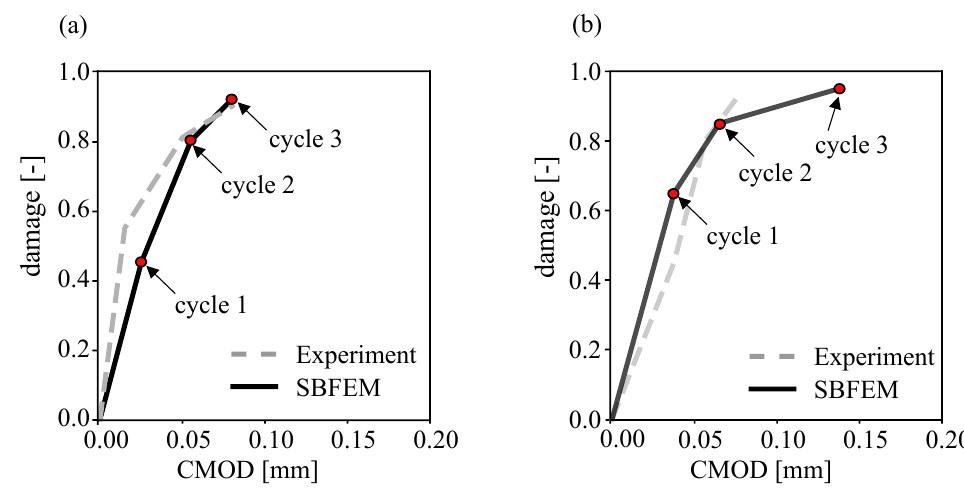
Figure 10. Post-peak cyclic behavior of SBFEM analysis and corresponding damage evolution for ( a ) a small beam and ( b ) a large